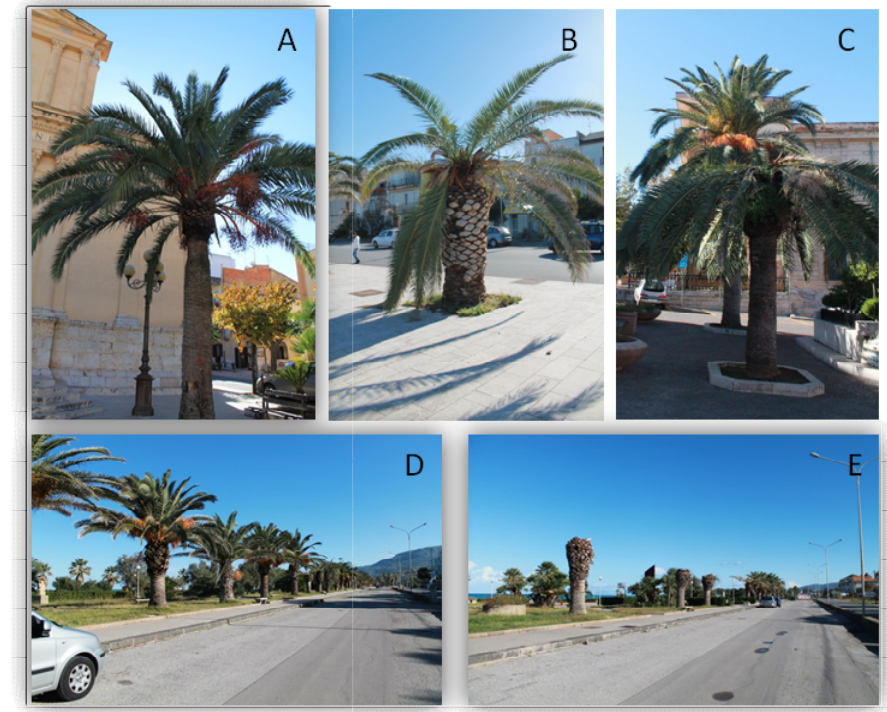
Figure 1 (A-E): Phoenix canariensis at different levels of infestation: (A) early symptoms; (B) symptomatic palm with loss of symmetry of the leaves of the canopy; (C) late symptoms on a plant with the leaves dried and hanging downward in a typical ‘umbrella shape’; Sant’Agata di Militello main road at the beginning (D) and at the end (E) of the monitoring period of the